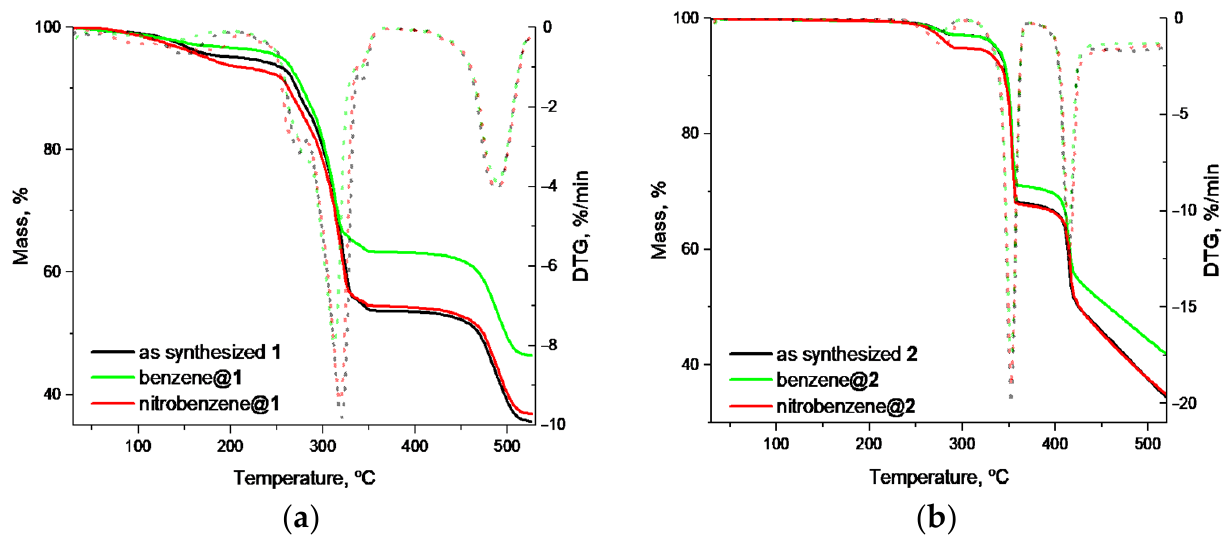
Figure 9. ( a ) TGA of as synthesized 1 , soaked in benzene and nitrobenzene; ( b ) TGA of as synthesized 2 , soaked in benzene and nitrobenzene.